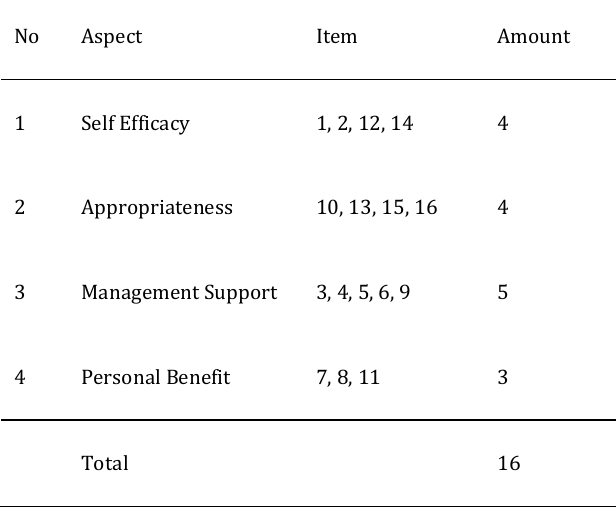
Table 4 The numbering of readiness for change scale after trying out No Aspect Item